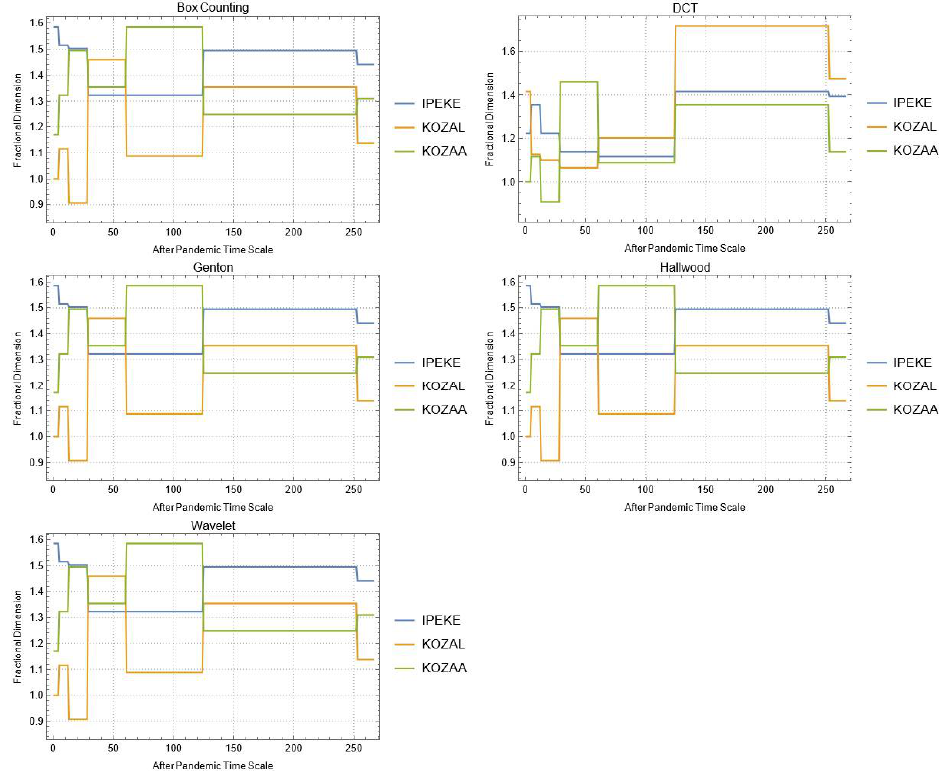
Figure A22. Daily changes of fractal dimensions after the pandemic (stone–soil-based manufacturing).